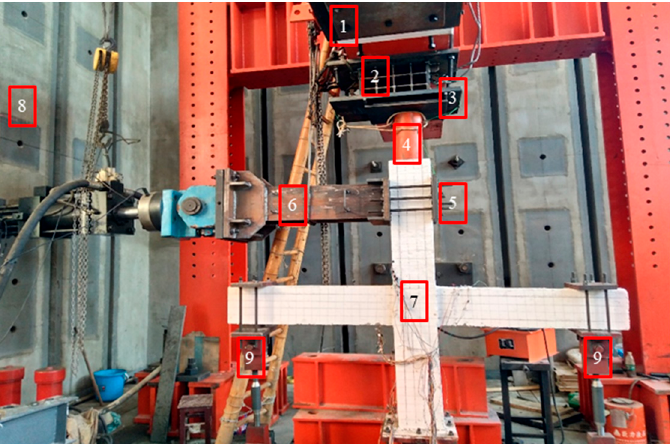
Figure 2. Loading device in the test: (1) Reaction beam; (2) rolling hinged support; (3) pressure sensor; (4) oil-pressure jack; (5) steel fixture for columns; (6) electrohydraulic servo actuator; (7) concrete joint; (8) back strength wall; (9) steel fixture for beams.